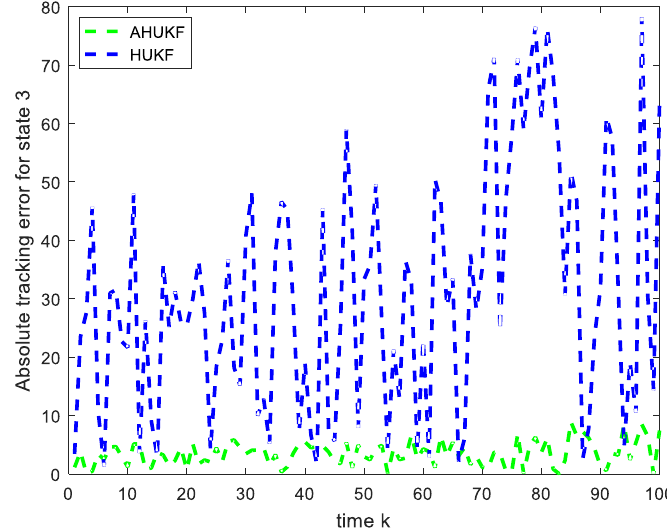
Figure 4. Tracking error curve for State 3.